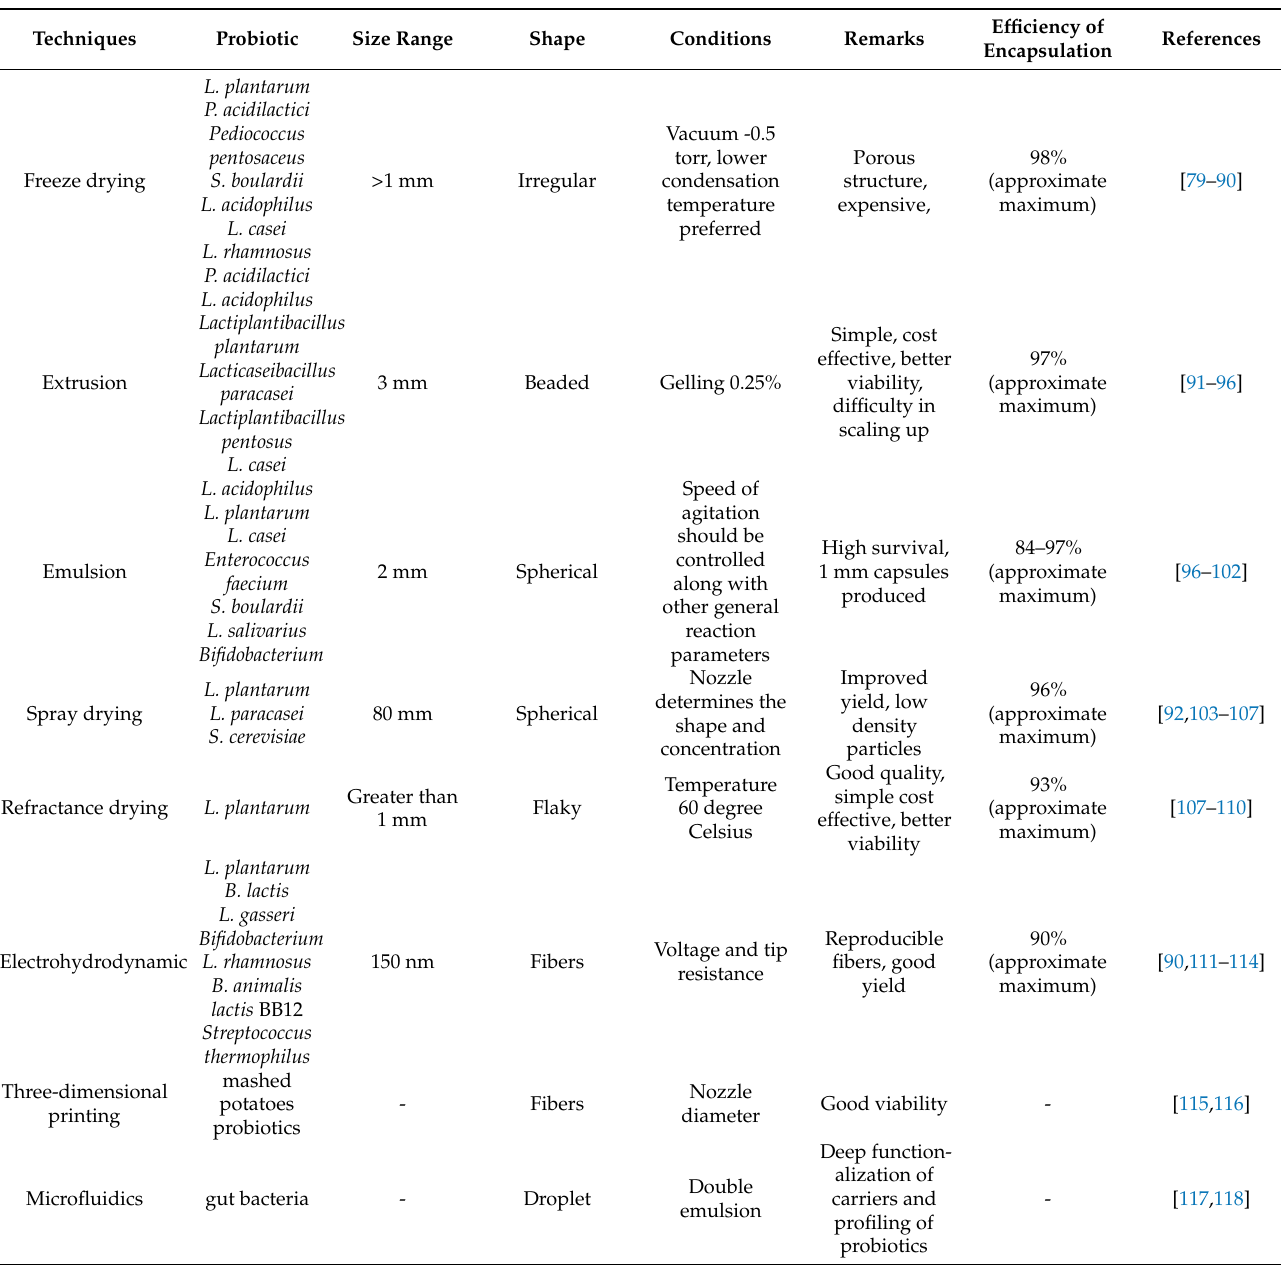
Table 2. Recent techniques used to enhance viability of probiotics for commercial